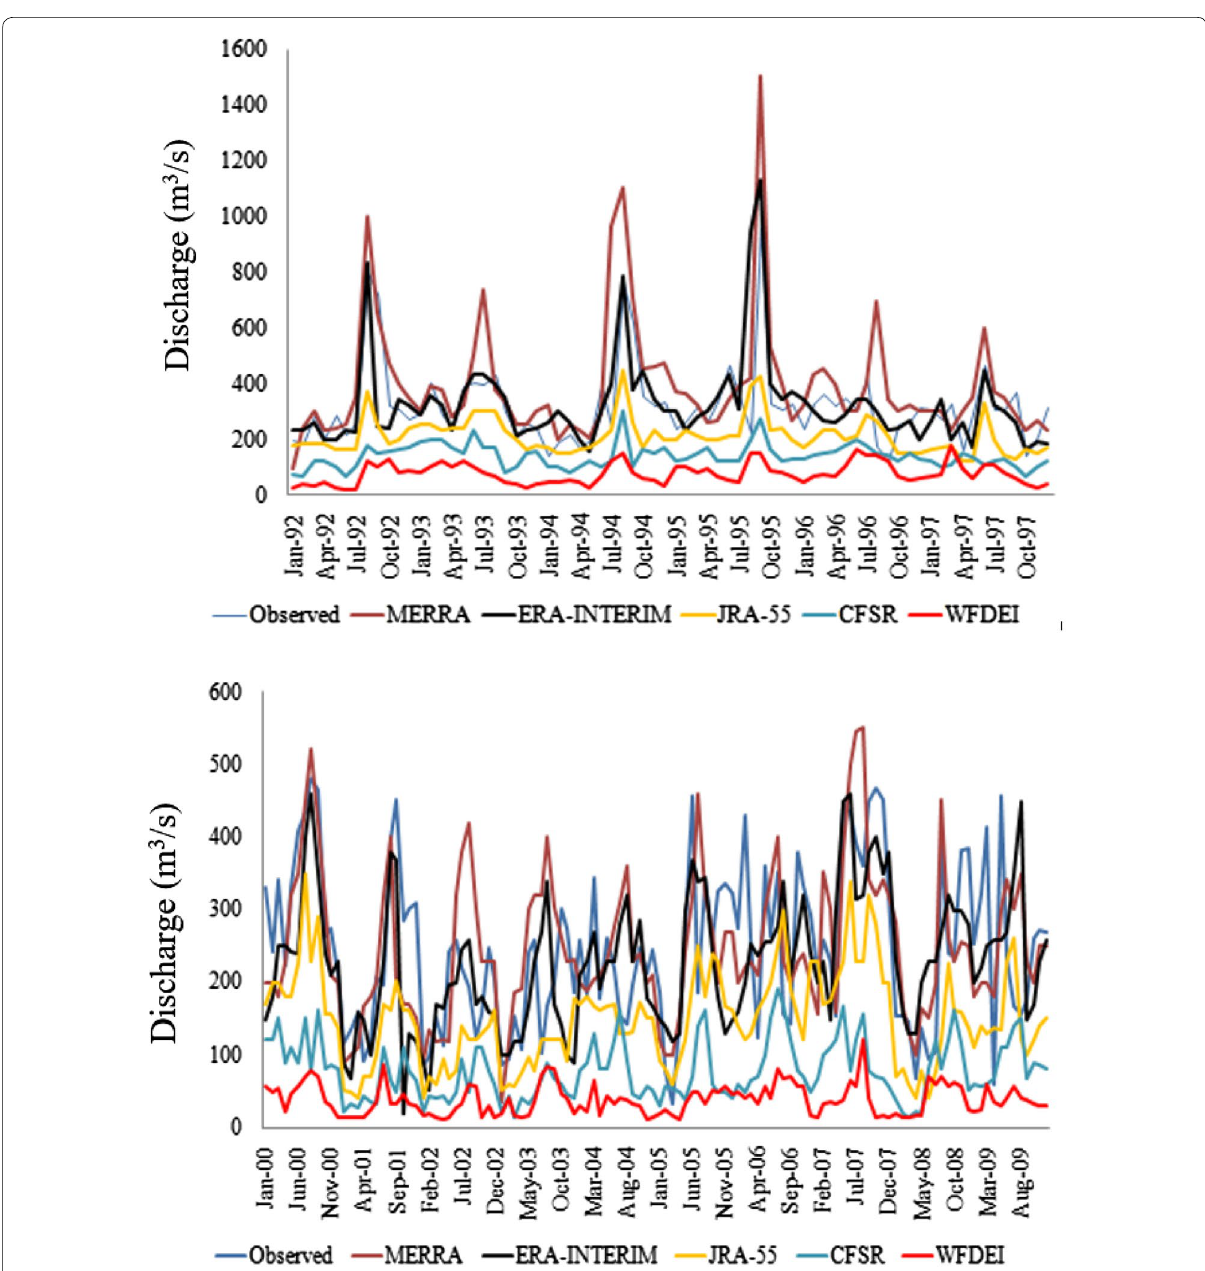
Fig.19 Hydrograph of observed and simulated flow of Pong dam for calibration period (1992–1997) and validation period